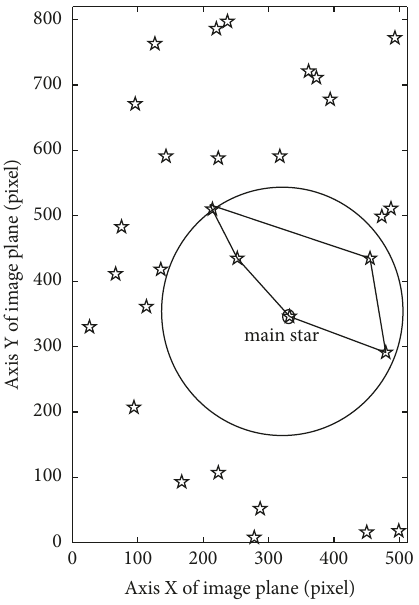
Figure 2: Optimal path in observed image.